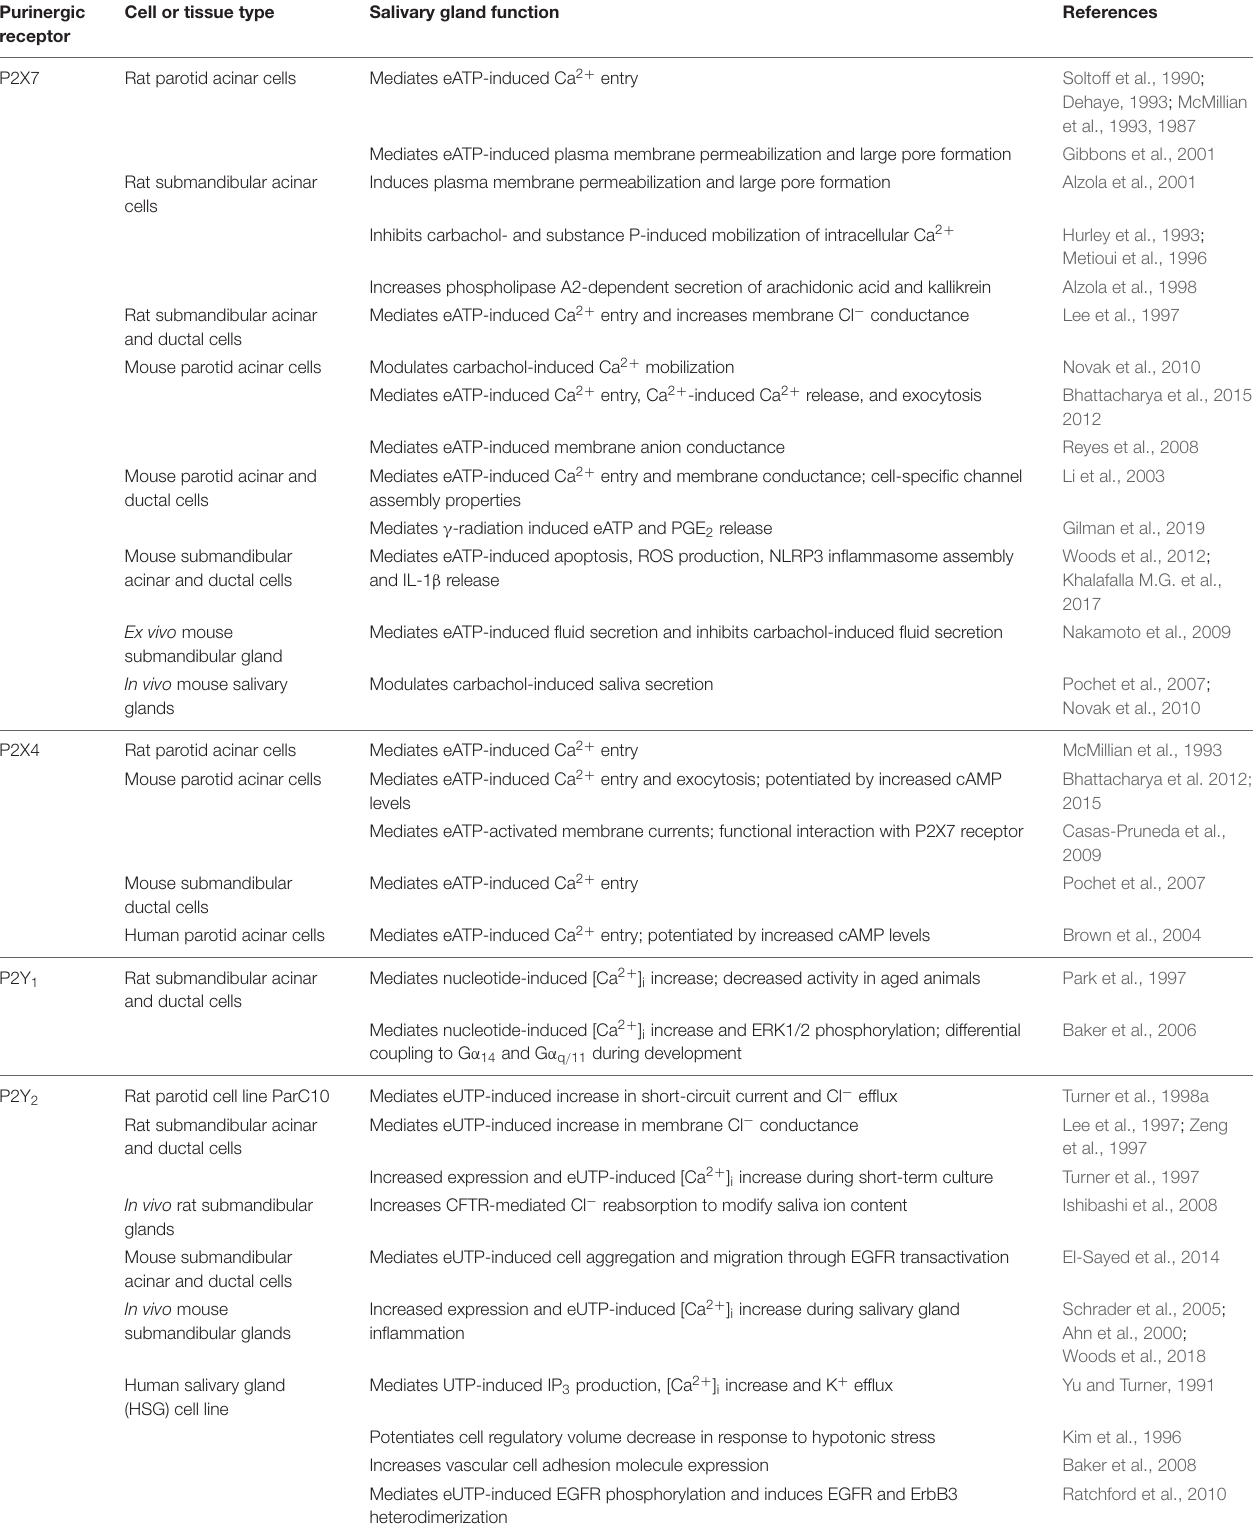
TABLE 1 | Expression and function of purinergic receptors in salivary